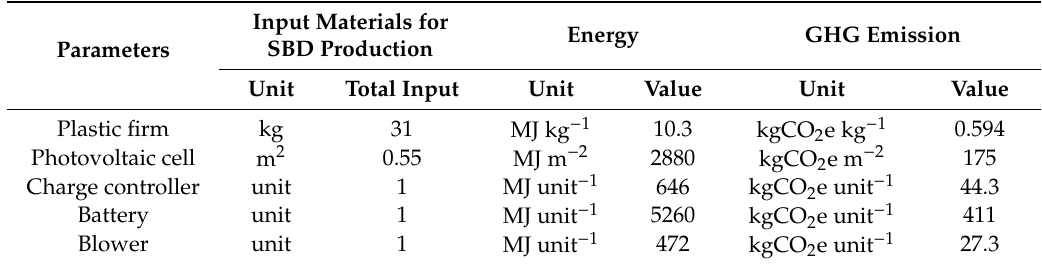
Table 2. Input materials for the SBD production and conversion factors of energy and greenhouse gas (GHG)